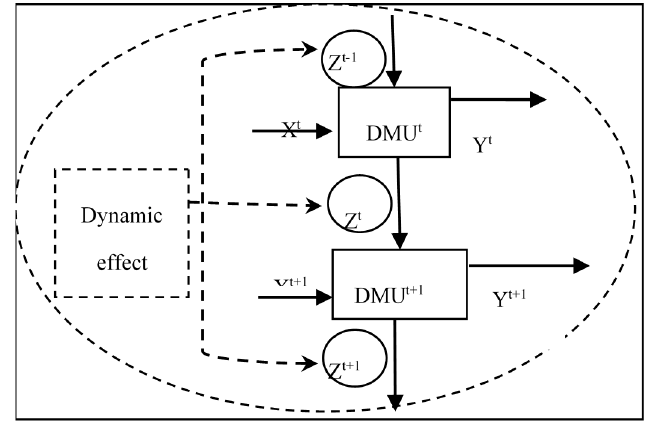
Figure 1. Dynamic Malmquist model structure.